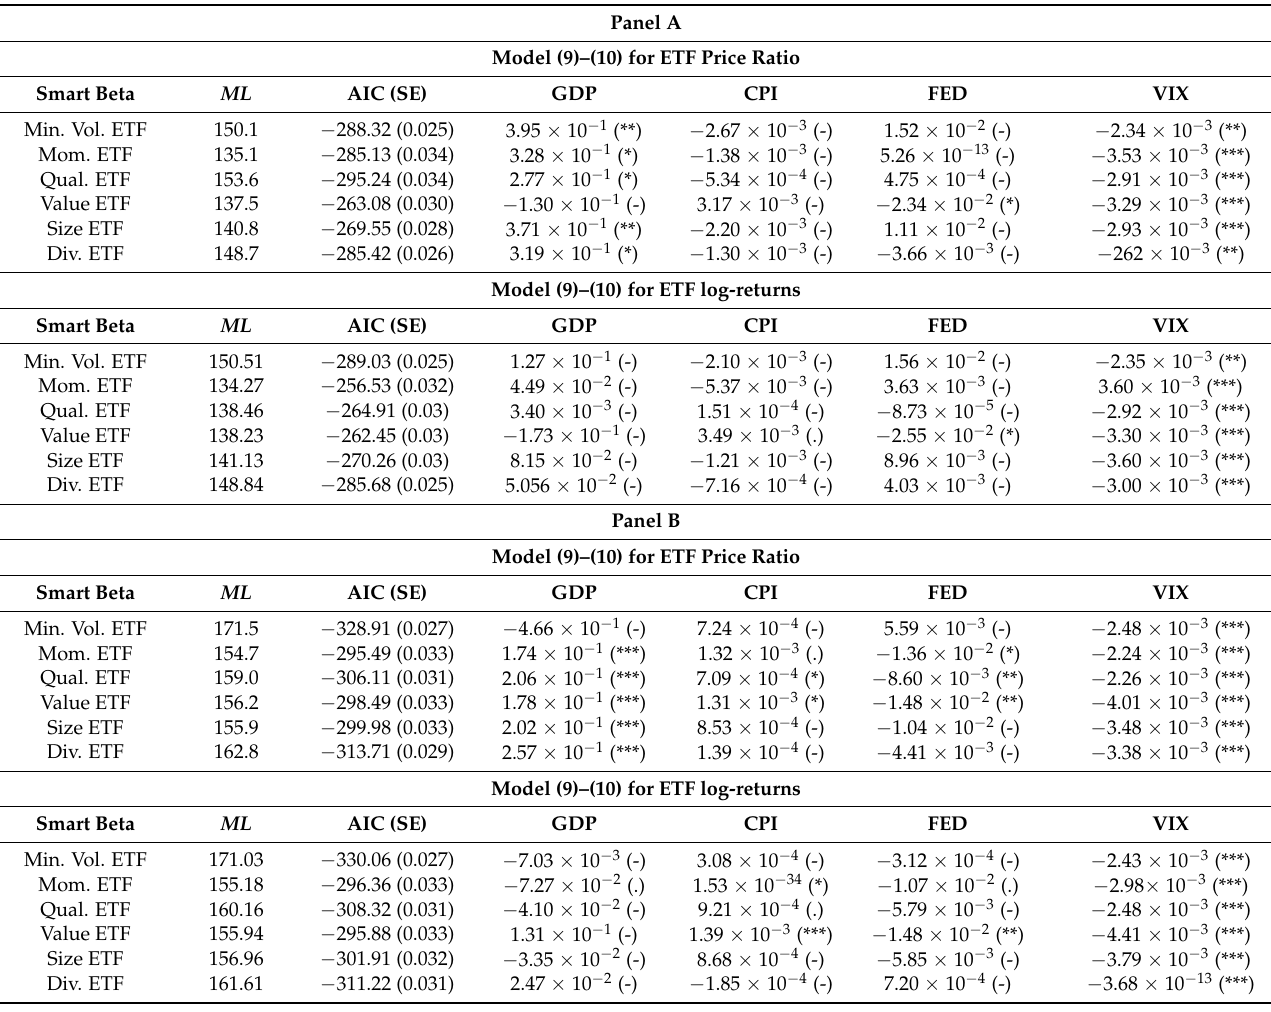
Table 3. Results of model (9) and (10) on smart beta. Panel A includes data from January 2014 to May 2019, Panel B from January 2014